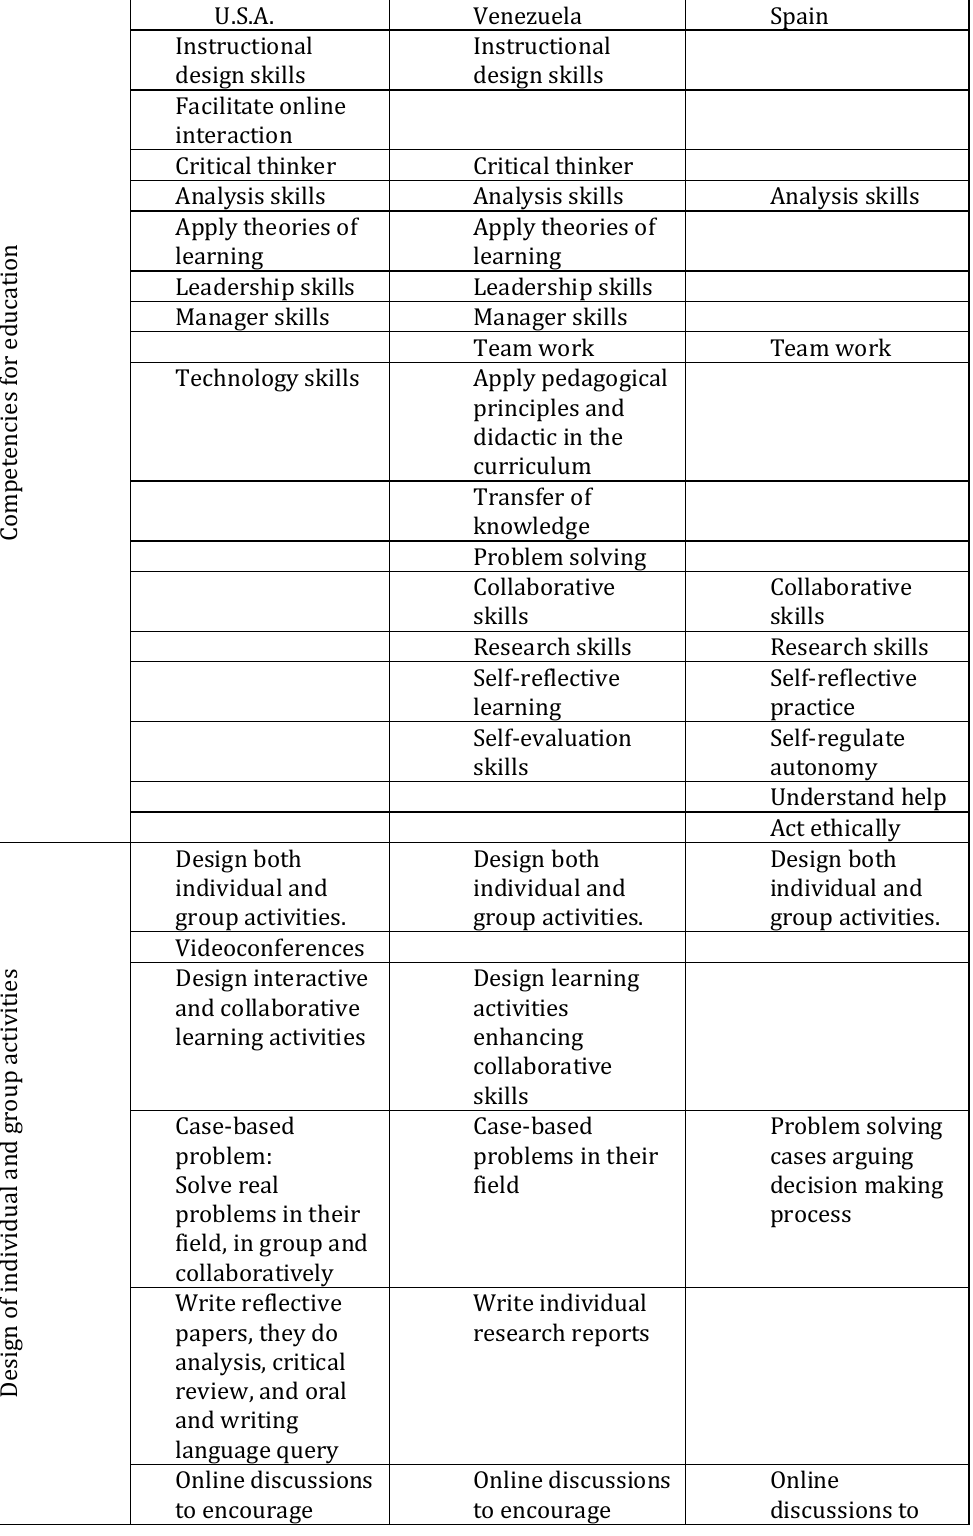
Competencies and Design of Interaction for Education Across Three